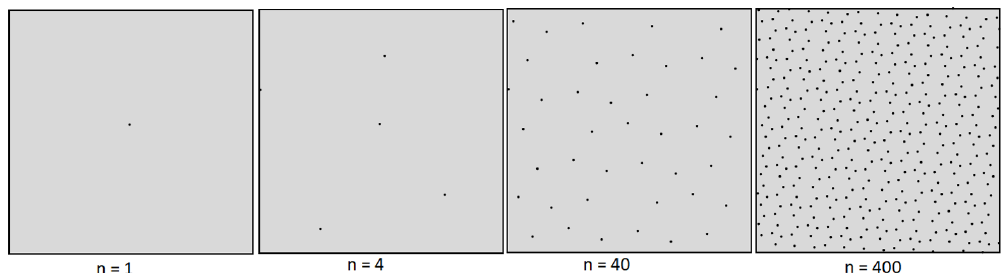
Figure 3. Example particle distributions using the R 2 sequence, note that while not all particles are equidistant, the method produces distributed particle patterns that adapt well to varying density.